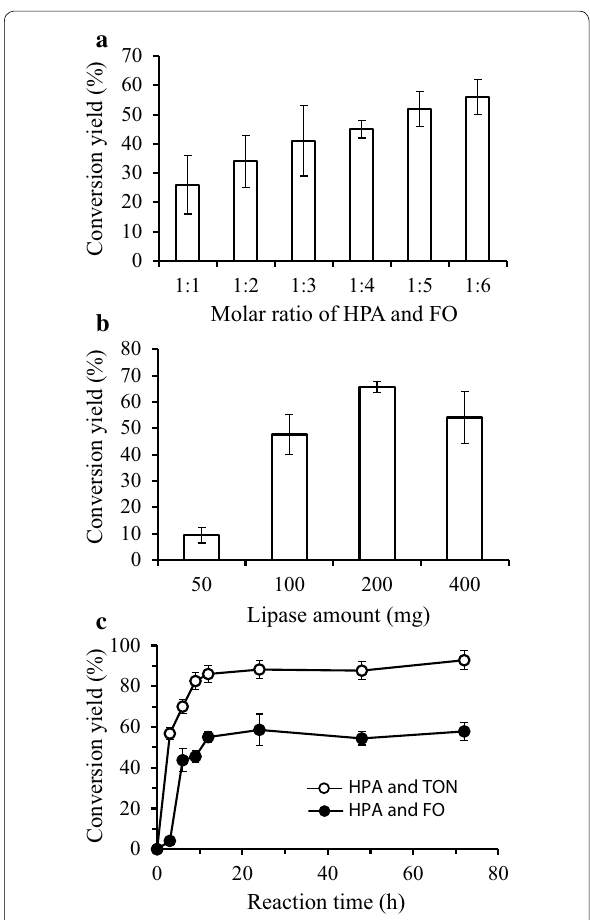
Fig. 1 Effect of substrate concentration, enzyme amount, and reaction time on conversion yield. a Transesterification reaction was performed using 40 mM HPA and various concentrations (40–240 mM) of Menhaden fish oil. b Transesterification reaction was performed using 40 mM HPA, 240 mM FO, and various amounts (50–400 mg) of CalB lipase. c Conversion yields were measured with time course. ○ , reaction using HPA and TON; ● , reaction using HPA and